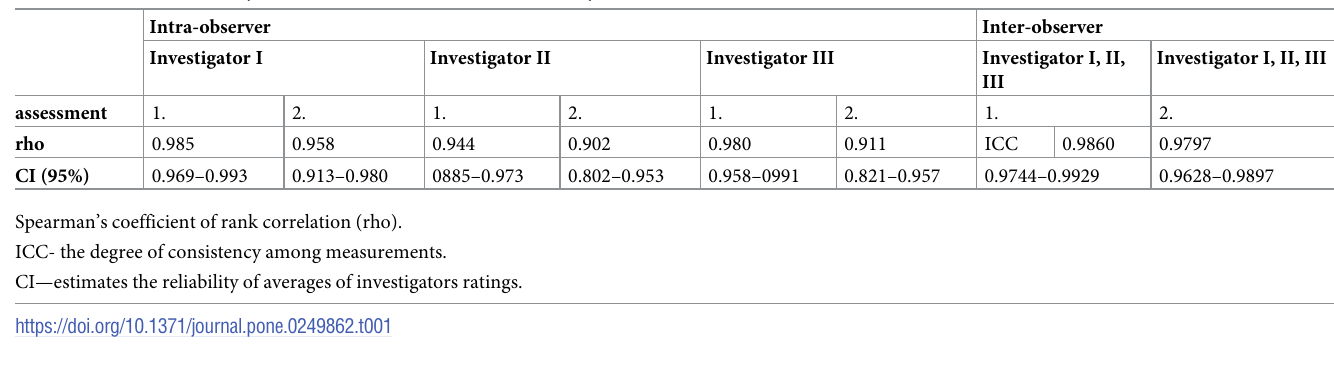
Table 1. Data from the analysis of intra- and inter-observer variability.